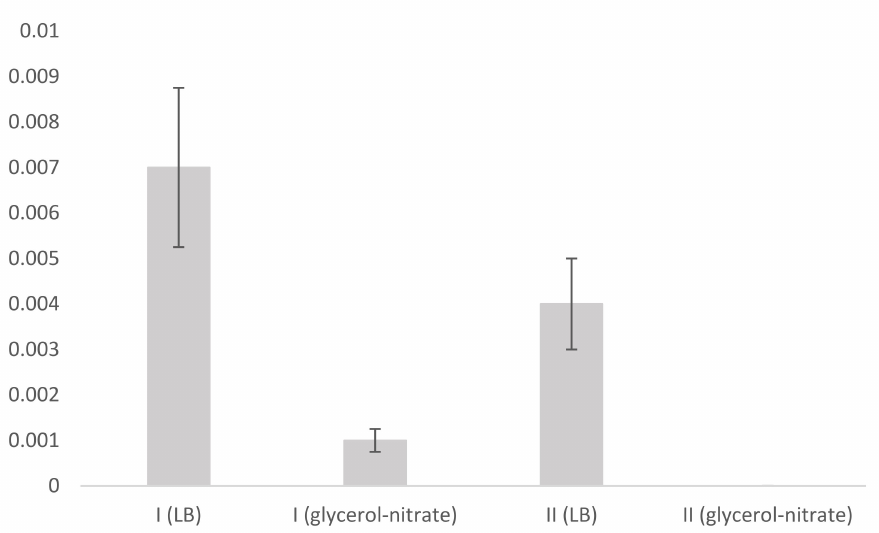
Figure 5. Relative expression of the rhlB -encoding rhamnotrasferase 1 (I) and rhlC -encoding rhamno- transferase 2 (II) genes in P. putida PP021 grown on LB and glycerol nitrate